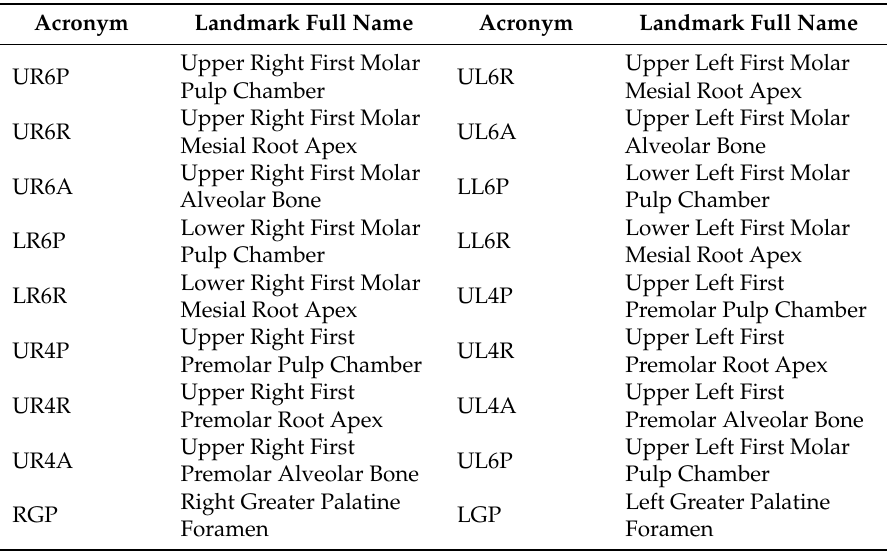
Table 2. Dental and skeletal landmarks used in the study.